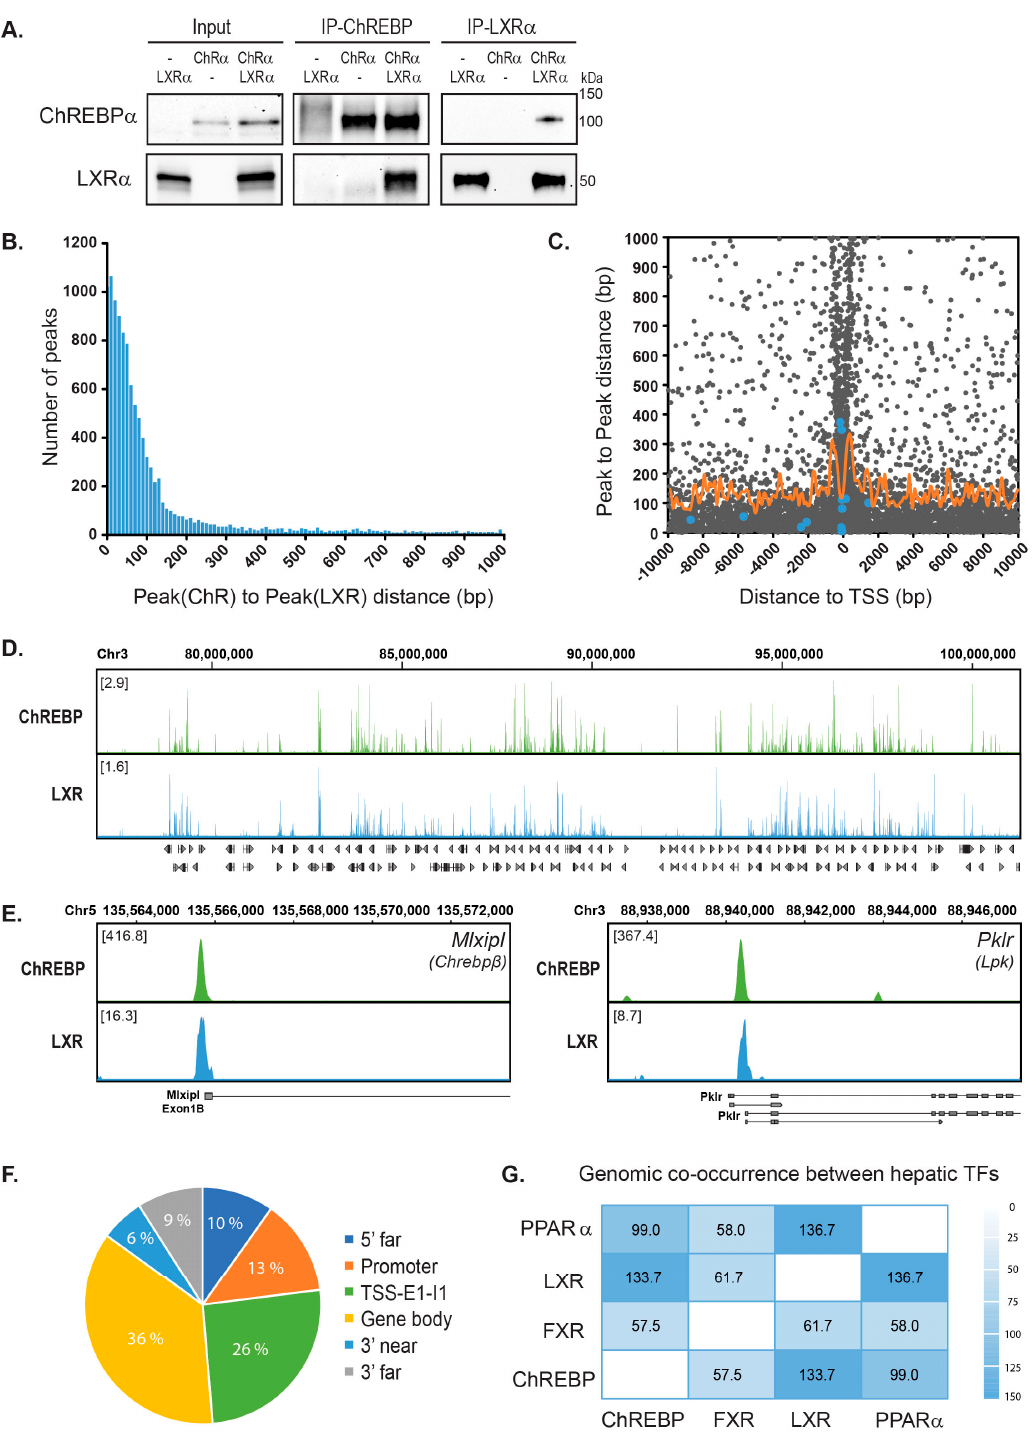
Figure 1. Genome-wide co-occupancy of carbohydrate responsive element-binding protein (ChREBP) and liver X receptor (LXR) in mouse liver. ( A ). Co-immunoprecipitation (CoIP) of LXR α and ChREBP α transfected in COS-1 cells cultured in 25 mM glucose. Lysates were immunoprecipitated with ChREBP and LXR α antibodies and input and immunoprecipitated proteins immunoblotted with the same antibodies ( n = 3). One representative western blot is shown. ( B ). Distribution of ChREBP-LXR peak pairs. ChREBP ChIP-seq data from fasted and high-carbohydrate refed mouse liver [42] and LXR ChIP-seq data from T0901317-treated mouse liver [43] were reanalyzed to generate a genome-wide map of ChREBP and LXR binding sites. The top 20,000 peaks from each dataset were used to